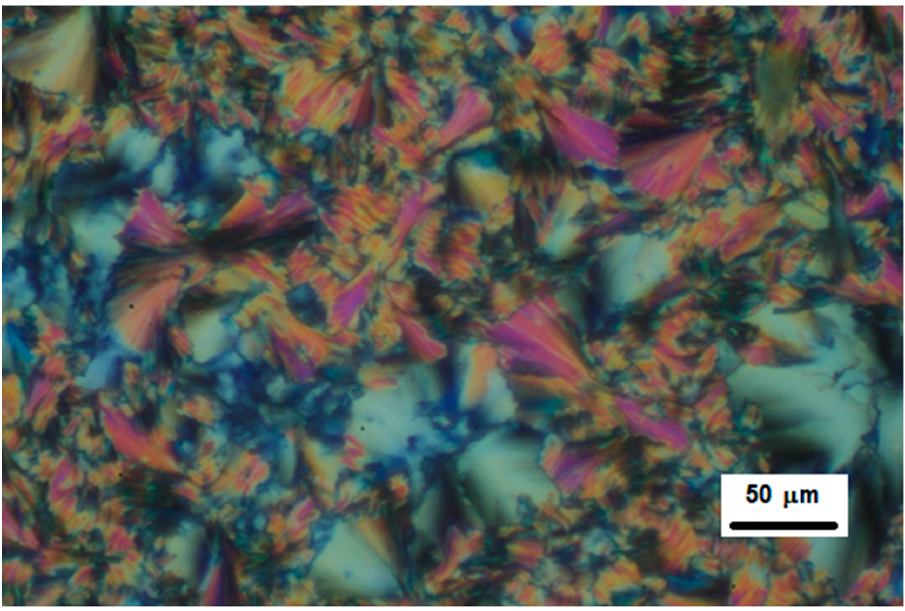
Figure 6. The focal ‐ conic texture of EV8 obtained at 160 °C on cooling from the isotropic phase (magnification 200×).